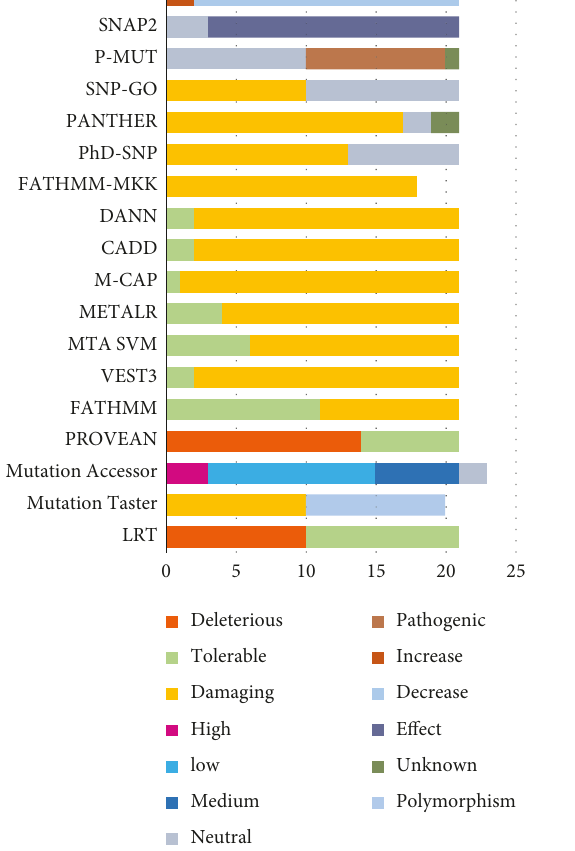
Figure 3: Prediction results of the 21 SIFT and PolyPhen2 dele- terious nsSNPs in the ELANE gene analyzed by the eighteen computational tools.